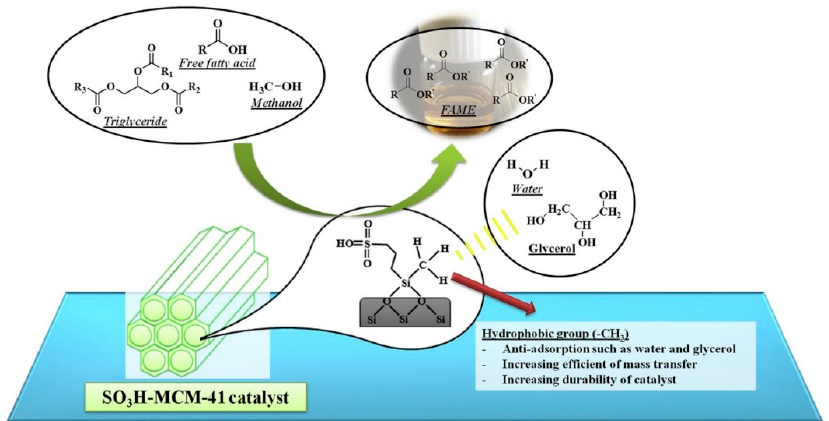
Figure 12. Graphical representation. Reproduced with permission from [19]. Copyright 2016 Elsevier B.V.